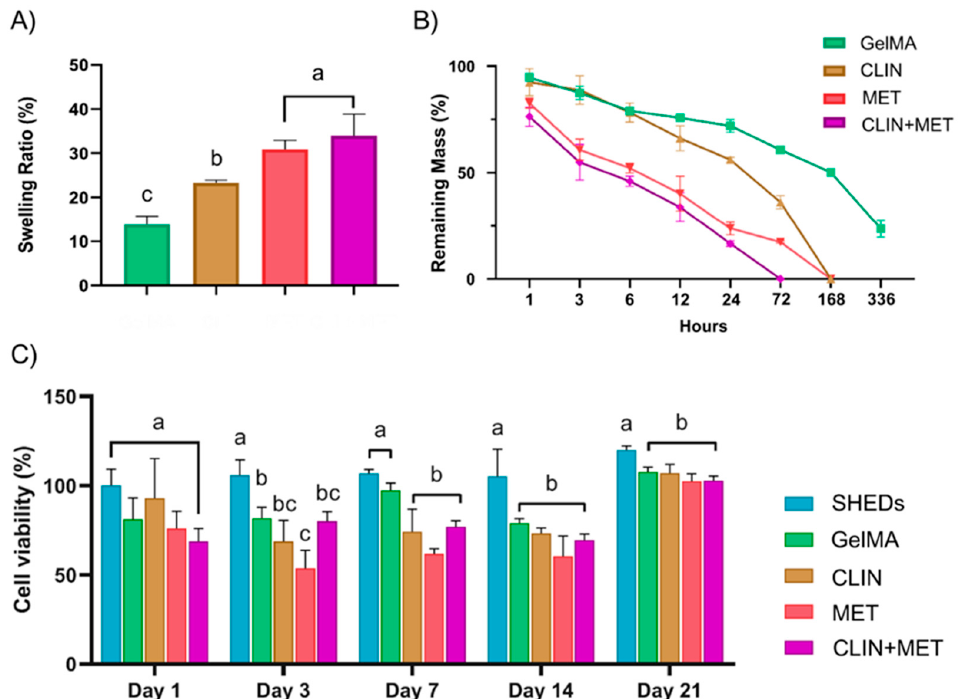
Figure 2. Graphs showing the swelling ratio ( A ), the degradation profile ( B ), and the cell viability ( C ) of the engineered hydrogels. The swelling ratio (%) results indicate the amount of water absorbed by the hydrogels within a 24 h period at 37 °C. The results for the in vitro degradation test reveal the mass loss of all hydrogels after exposure to DI water containing 1 U/mL of collagenase type I at 37 °C for 336 h. The results for the viability of stem cells from exfoliated deciduous teeth (SHEDs) were obtained indirectly using an MTS assay after 24 h of cell exposure in response to aliquots of the hydrogels at days 1, 3, 7, 14, and 21. The percentage of cell viability was normalized by the mean absorbance of SHEDs cultured at day 1 (100%). All the results are presented as mean ± SD values ( n = 4/group). Distinct letters above the standard deviation bars indicate statistically significant differences among the groups ( p < 0.05). GelMA, gelatin methacryloyl hydrogel; CLIN, Clindamycin; MET, metronidazole.